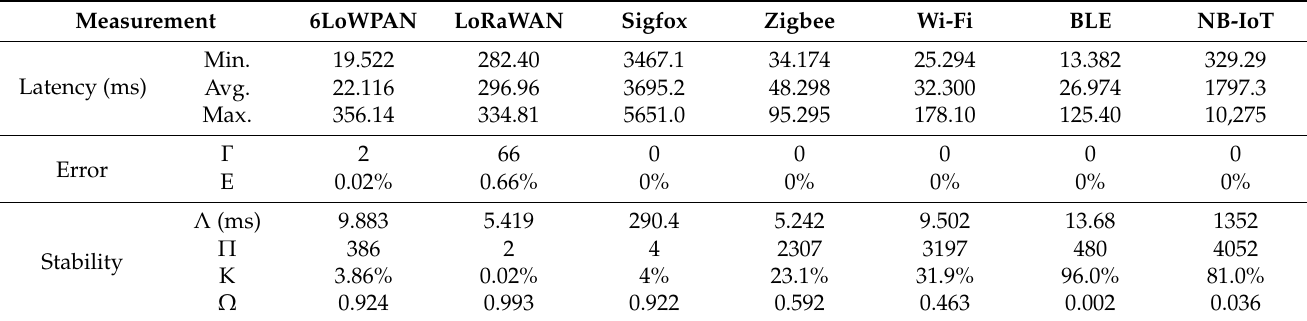
Table 4. Results